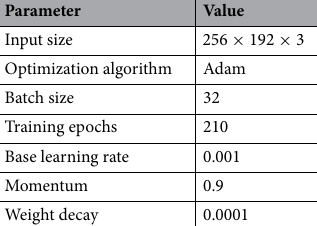
Table 2. Configuration of the training